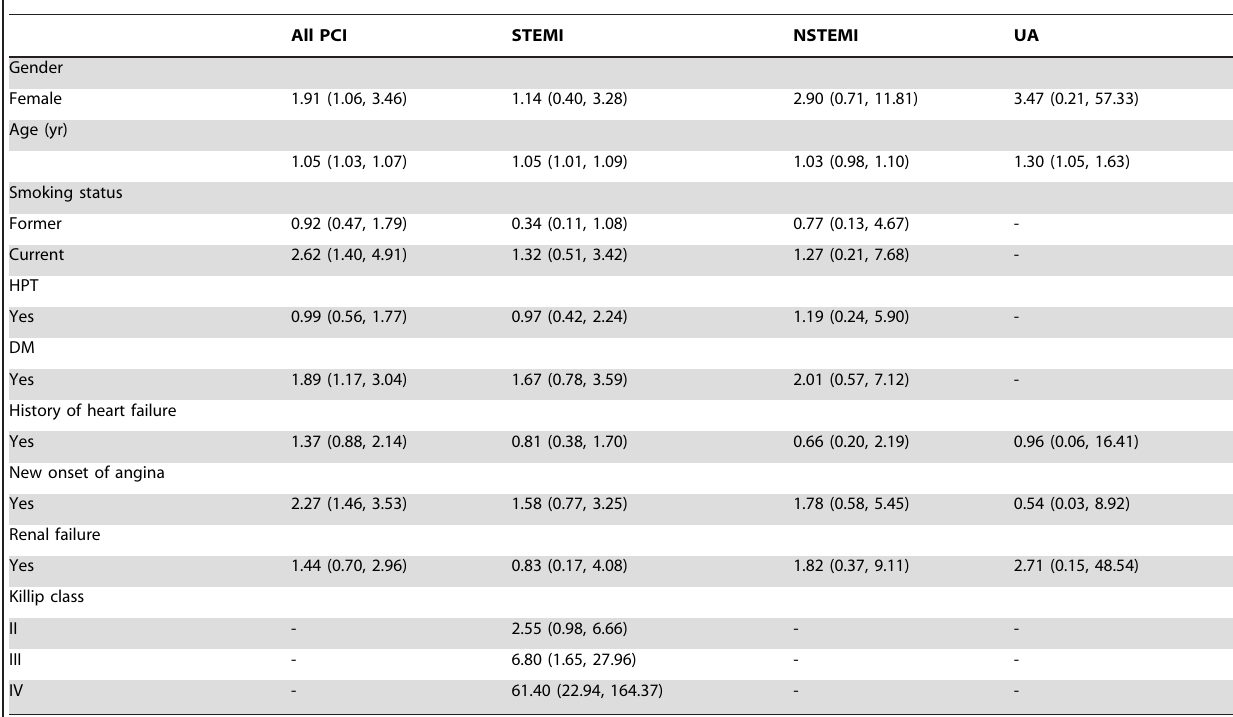
Table 4. Risk of mortality at discharge for total population